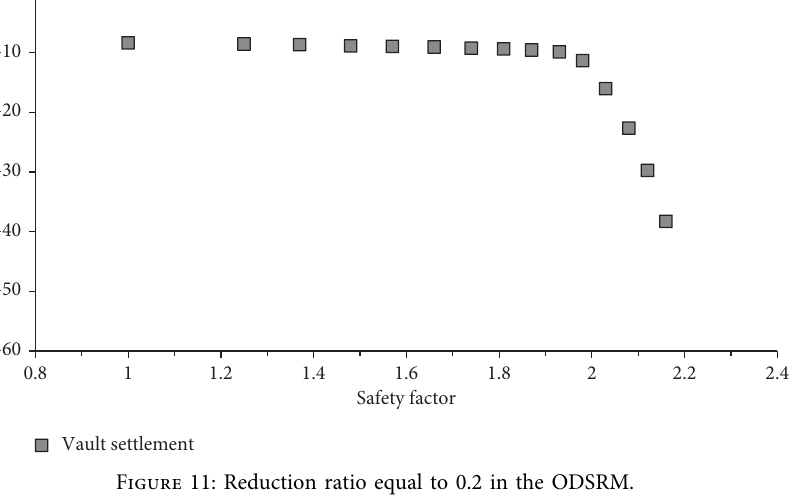
Figure 11: Reduction ratio equal to 0.2 in the ODSRM.